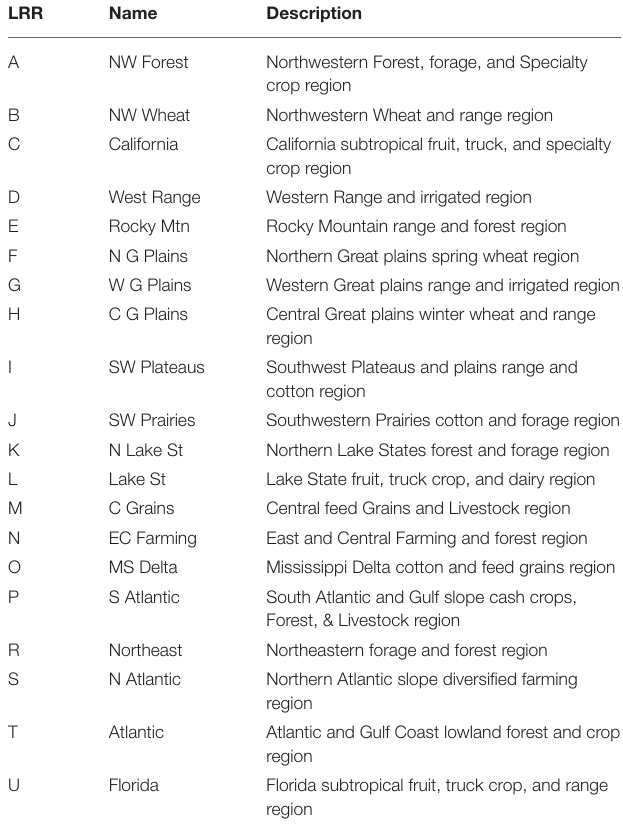
TABLE 1 | USDA Land Resource Regions (USDA, 2006).